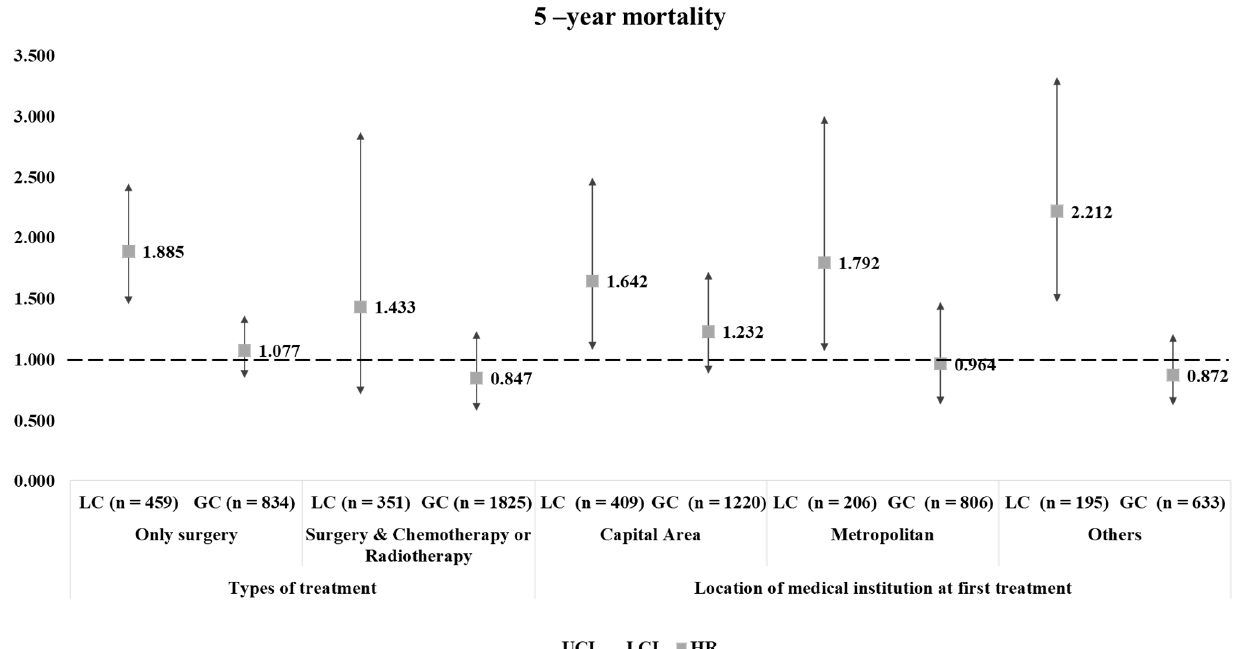
Figure 3. Results of the subgroup analysis on the association between time to surgical treatment and mortality.